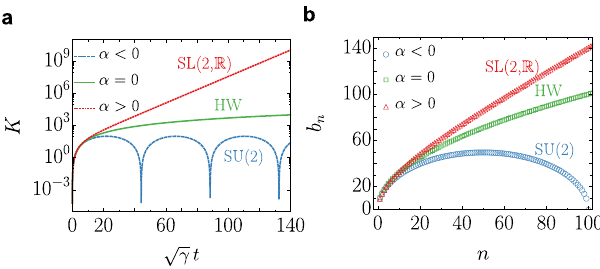
Fig. 1 Growth of Krylov complexity at the speed limit. Saturation of the dispersion bound occurs in three different scenarios, each of which is associated with a different complexity algebra that is speci fi ed by the sign of α . a Time-dependence of the Krylov complexity. b The corresponding growth of the Lanczos coef fi cients in the Krylov lattice. The plots are representative of the three different scenarios. The Krylov dimension in the SU(2) case is D = 100, and in fi nite in all other cases. In b we choose α = 4 and − 4 for the SL ð 2 ; R Þ and SU(2) algebras, respectively, while α is always zero in the HW case. Finally, the parameter γ in b is chosen in each case such that the corresponding Lanczos coef fi cients share the same behavior near the origin of the Krylov lattice. Speci fi cally, γ = 202, 200, and 198 for the SL ð 2 ; R Þ , HW and SU(2) algebras,